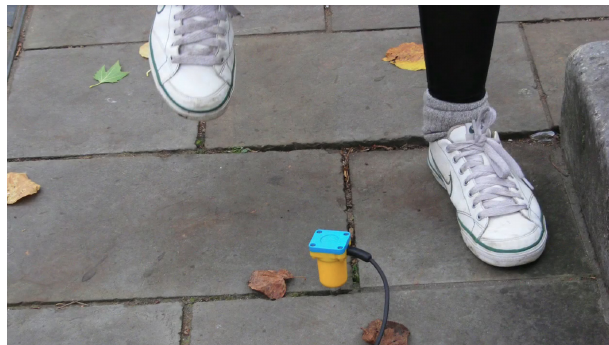
Figure 2. Workshop participant jumping near geophone set up to record foot traffic near the Wills Memorial